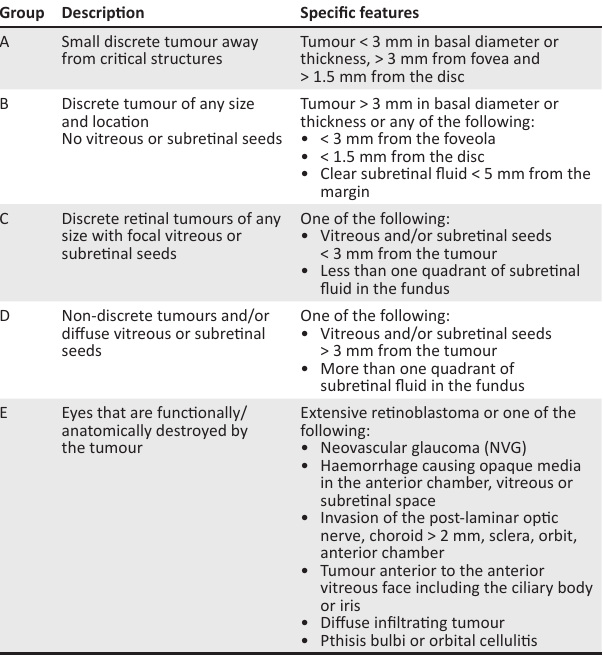
TABLE 1: The International Classification System for intraocular retinoblastoma. Group Description Specific features